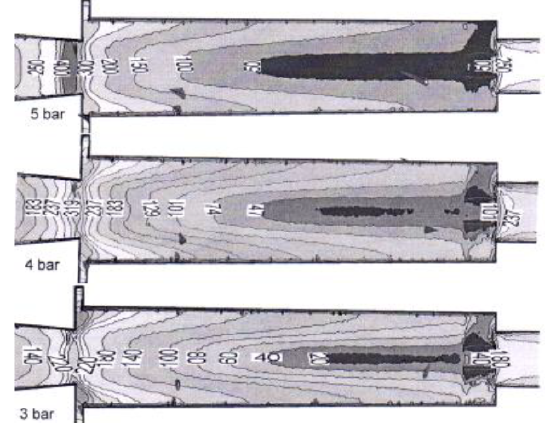
Figure 22. Velocity magnitude contours distribution along axial cross section of vortex tube at different inlet pressure.